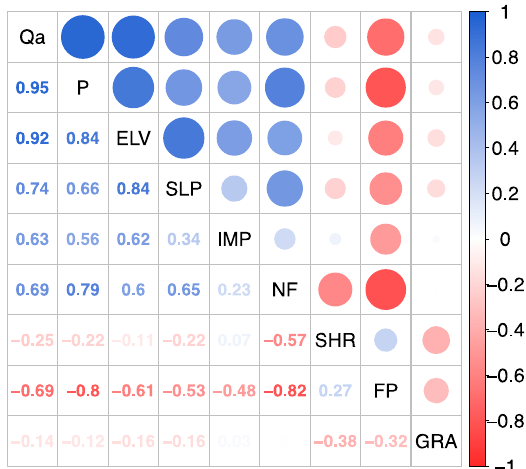
Figure 4. Correlation matrix of the pair-wise Pearson correlation coefficients between catchment attributes (Qa: mean annual runoff; P: mean annual precipitation; ELV: mean basin elevation; SLP: mean basin slope). The blank cells in the heatmap correspond to non-statistically significant correlations at 95% confidence interval.